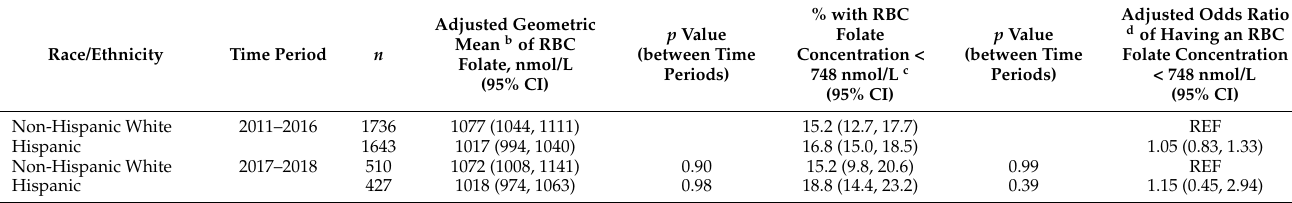
a Abbreviations: National Health and Nutrition Examination Survey (NHANES), red blood cell (RBC); b Geometric means adjusted for age, education, poverty-income ratio (PIR), and body mass index (BMI); c Associated with NTD rate of ≥ 9 per 10,000 live births; d Odds ratios adjusted for age, education, PIR, and BMI; p -values determined using Student’s t -test, examining differences between the two time periods within the race-ethnicity